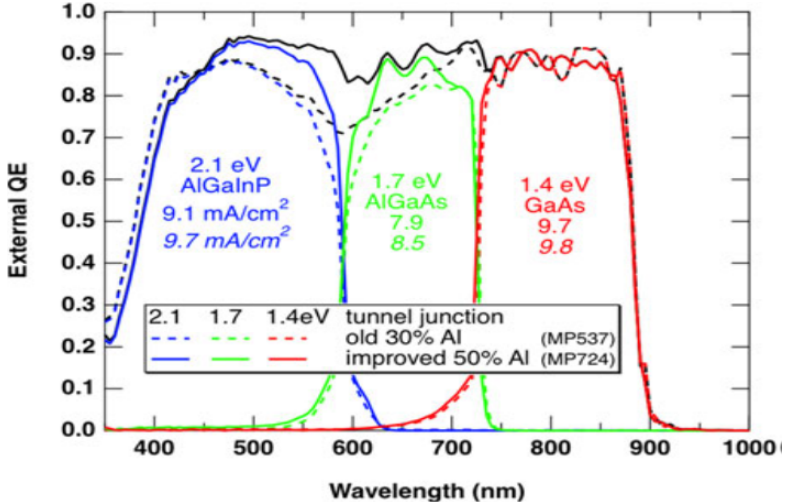
Figure 2. EQE of inverted triple-junction solar cells that will form the top junctions of a 6J cell. The dashed lines use the old nontransparent TJ that consists of n and p Al 0.3 Gal 0.7 As layers with a 12-nm GaAs QW while the solid lines use a more transparent TJ